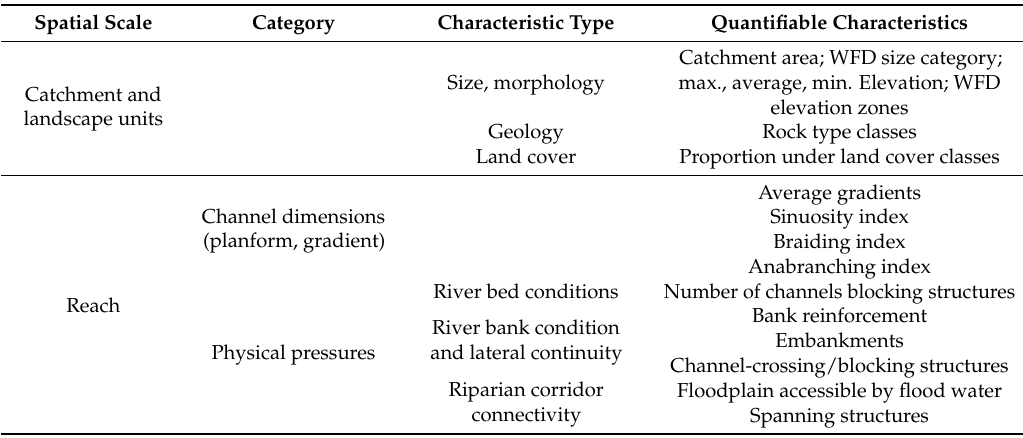
Table 2. List of characteristics extracted at different spatial